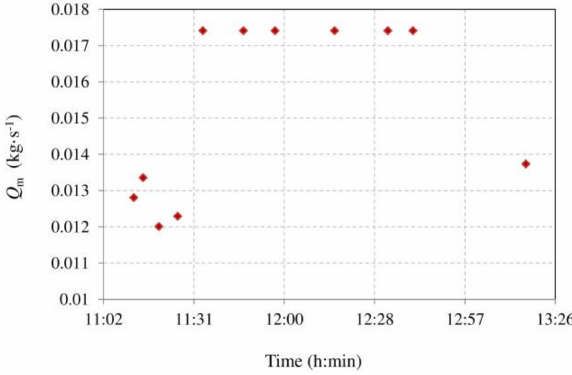
Figure 12. Mass flow rate of the gas flowing through the